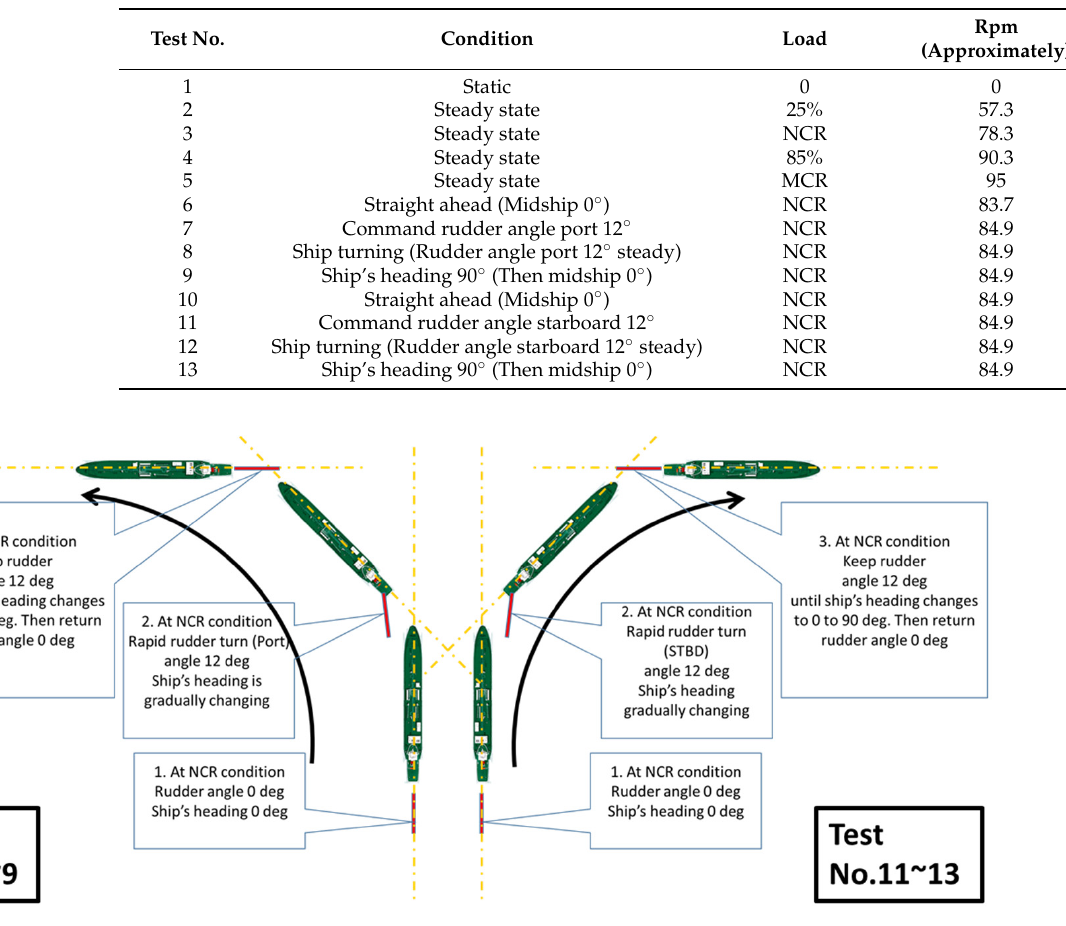
Figure 7. Sea-trial procedure for the case study ship.